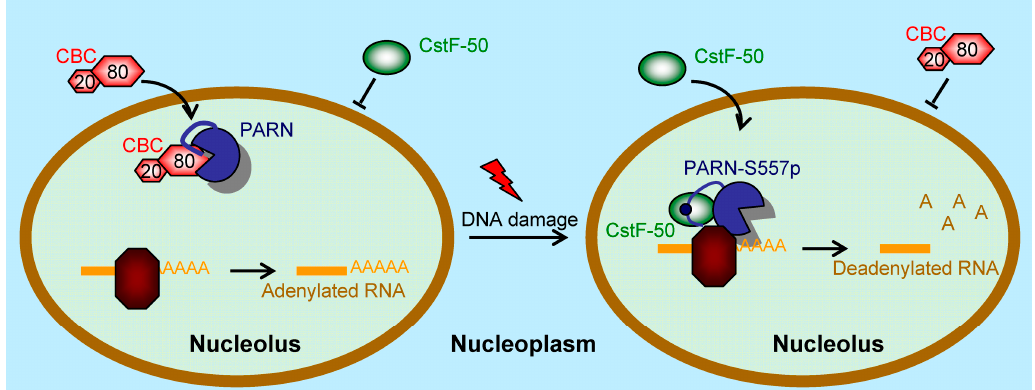
Figure 9. A working model of the function switch of PARN in the nucleoli during DNA damage response (DDR). Under normal conditions, PARN recruits the CBP80/CBC complex into the nucleoli and the deadenlyase activity is suppressed to facilitate RNA polyadenylation. During DDR, phosphorylation of PARN-S557 induces structure switch of the CTD to release CBP80 and expel the CBC complex from the nucleoli. Meanwhile, phosphorylated PARN prefers to bind with CstF-50 to enhance RNA deadenylation.